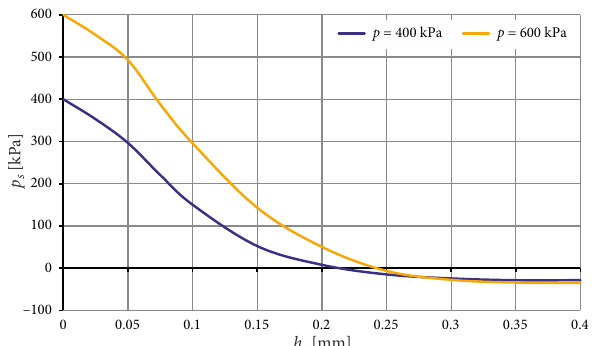
Figure 12. The dependence of the pressure p s in the measuring channel of the pneumatic sensor on the distance h c to the surface of the